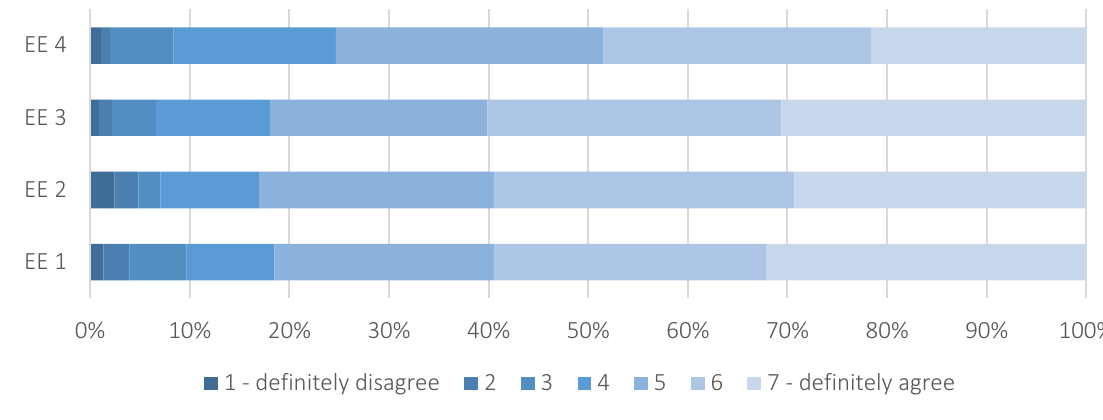
Figure 2. Summary of results for the expected effort Table 2. Summary of results for the expected effort factor